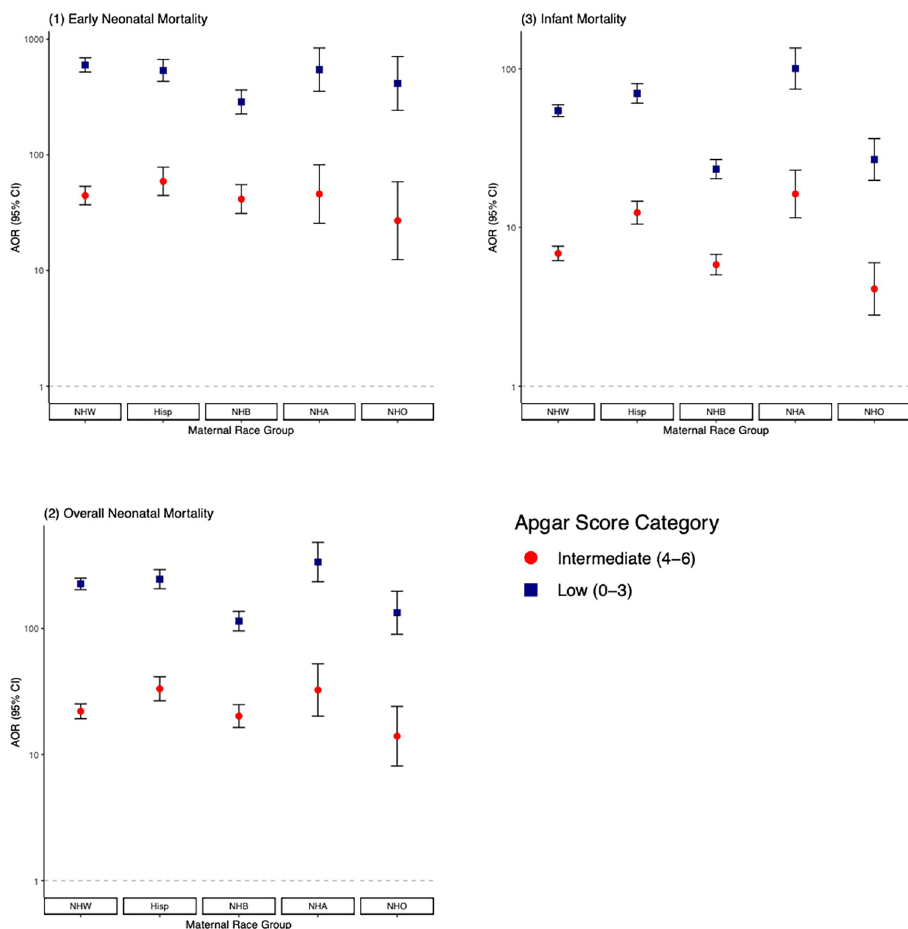
Fig 2. AORs and 95% CIs for early neonatal, overall neonatal, and infant mortality in relation to Apgar score, stratified by maternal race group ( n = 6,809,653). AORs of (1) early neonatal mortality; (2) overall neonatal mortality; and (3) infant mortality for infants with low (0 to 3) and intermediate (4 to 6) 5-minute Apgar scores referent to infants with normal (7 to 10) 5-minute Apgar scores. ORs were adjusted for infant sex, maternal age, maternal smoking status, infant birth weight, maternal education, maternal BMI, previous number of live births and gestational age. AOR, adjusted odds ratio; CI, confidence interval; Hisp, Hispanic; NHA, non-Hispanic Asian; NHB, non-Hispanic black, NHO, non-Hispanic other; NHW, non-Hispanic